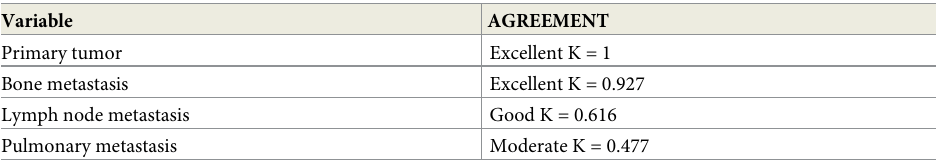
Table 4. Agreement between WBMRI and reference